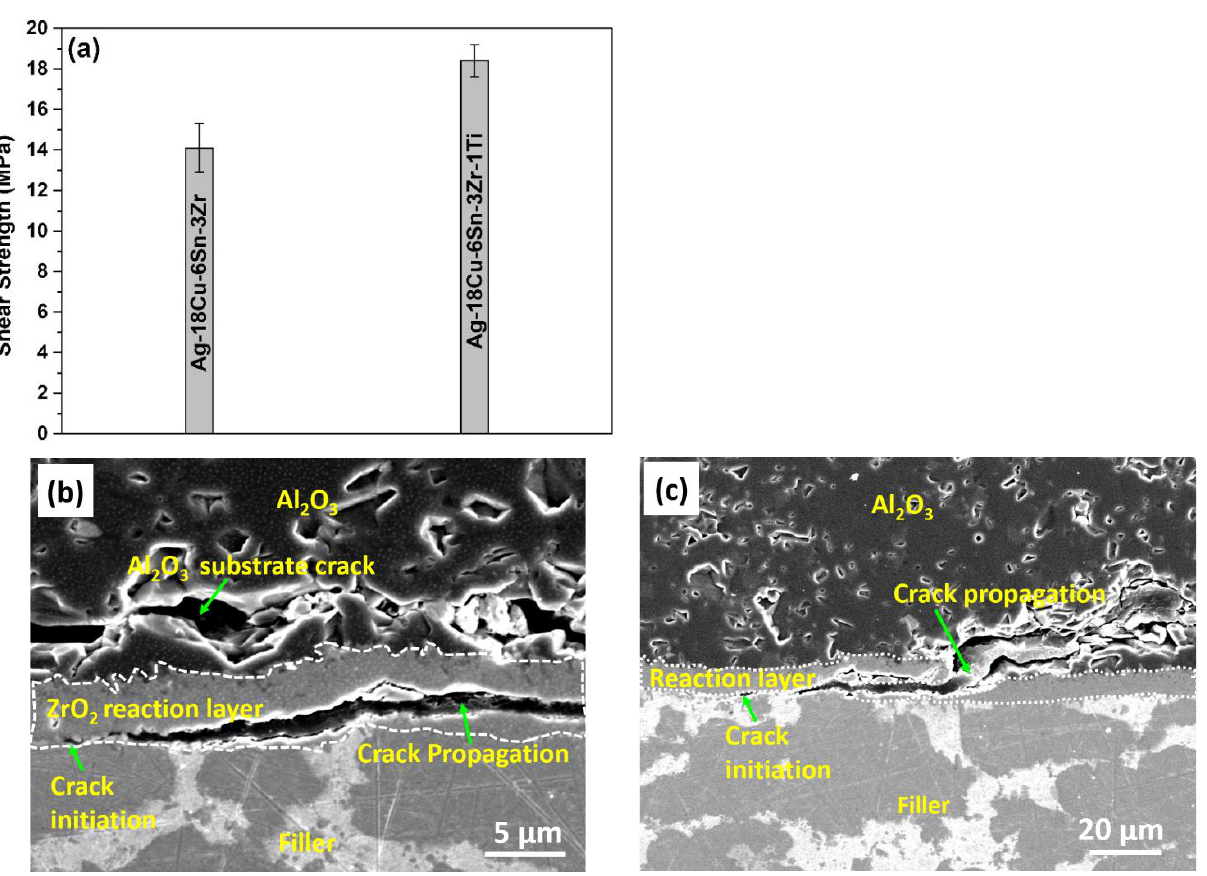
Figure 7. ( a ) Effect of brazing filler on the shear strength of Al 2 O 3 /Cu joints; ( b , c ) fracture analysis of Al 2 O 3 /Cu joints brazed, using Ag-18Cu-6Sn-3Zr and Ag-18Cu-6Sn-3Zr-1Ti, respectively.